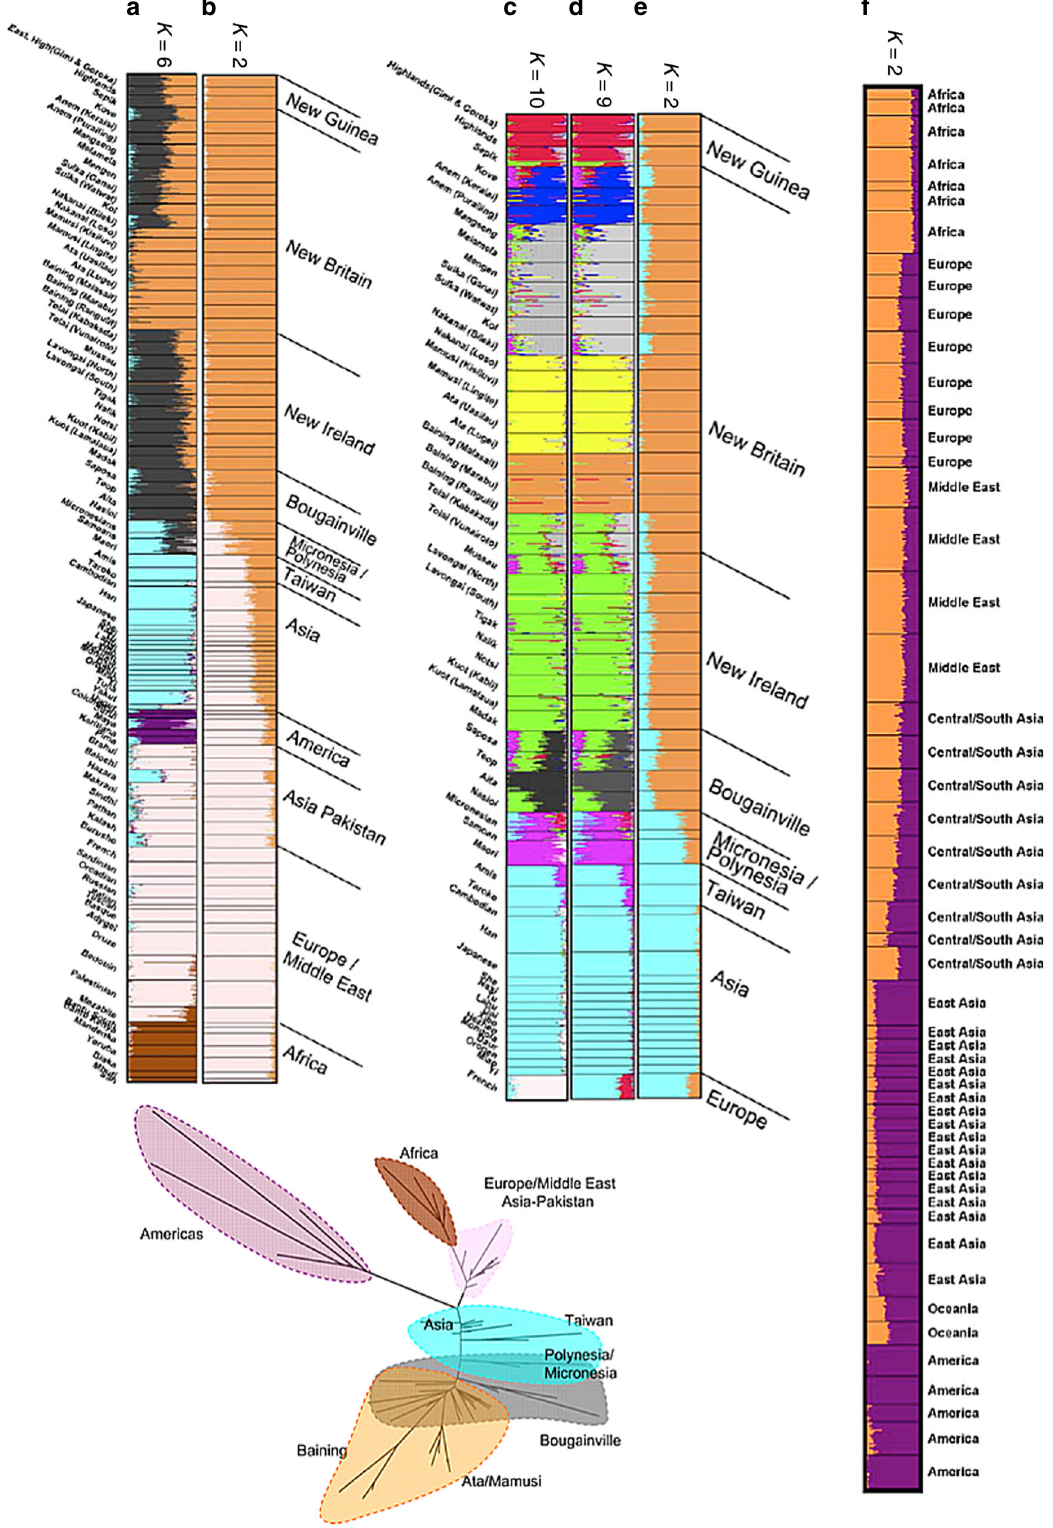
Fig. 5 STRUCTURE results for global human genetic data sets. Panels a – e reproduced from Friedlaender et al. 18 and f from Rosenberg et al. 19 . g reproduces the neighbour-joining F st tree 18 coloured according to K = 6 STRUCTURE results in